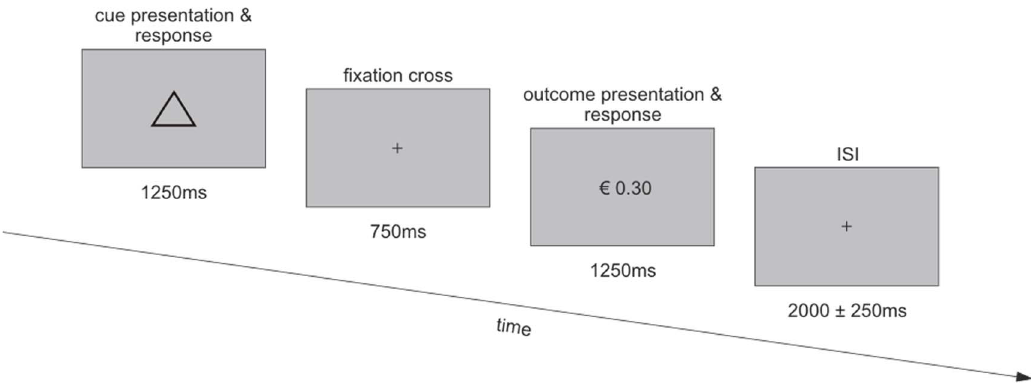
Figure 1. Experimental design. Visual cues predicted outcomes of high (1.00 J ) or low (0.30 J ) magnitude and high (0.7) or low (0.3) probability. Participants were initially familiarized with cue-reward associations in a conditioning phase (not shown; see methods section for